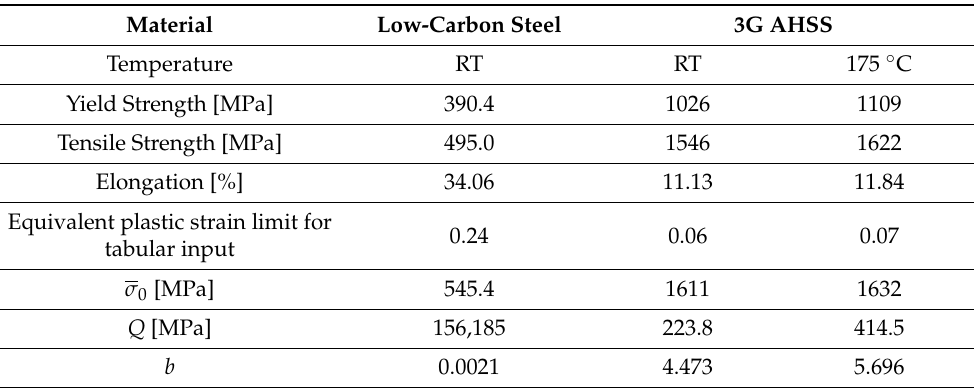
Figure 6. Flow stress–equivalent plastic strain curves of the sheet materials: ( a ) low ‐ carbon steel and ( b ) 3G AHSS. Table 2. Tensile properties and hardening parameters.